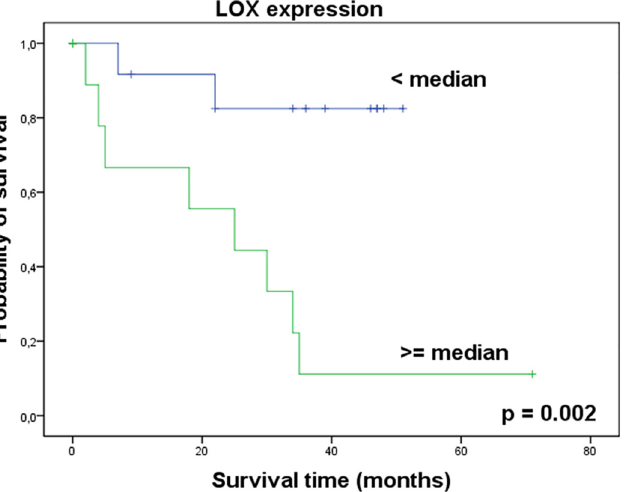
Fig 5. LOX mRNA expression is a prognostic marker in ccRCC. Kaplan-Meier analysis shows LOX mRNA expression in ccRCC tissue connected with overall survival of patients after nephrectomy. Higher LOX expression was significantly associated with a decrease in overall survival. Log rank